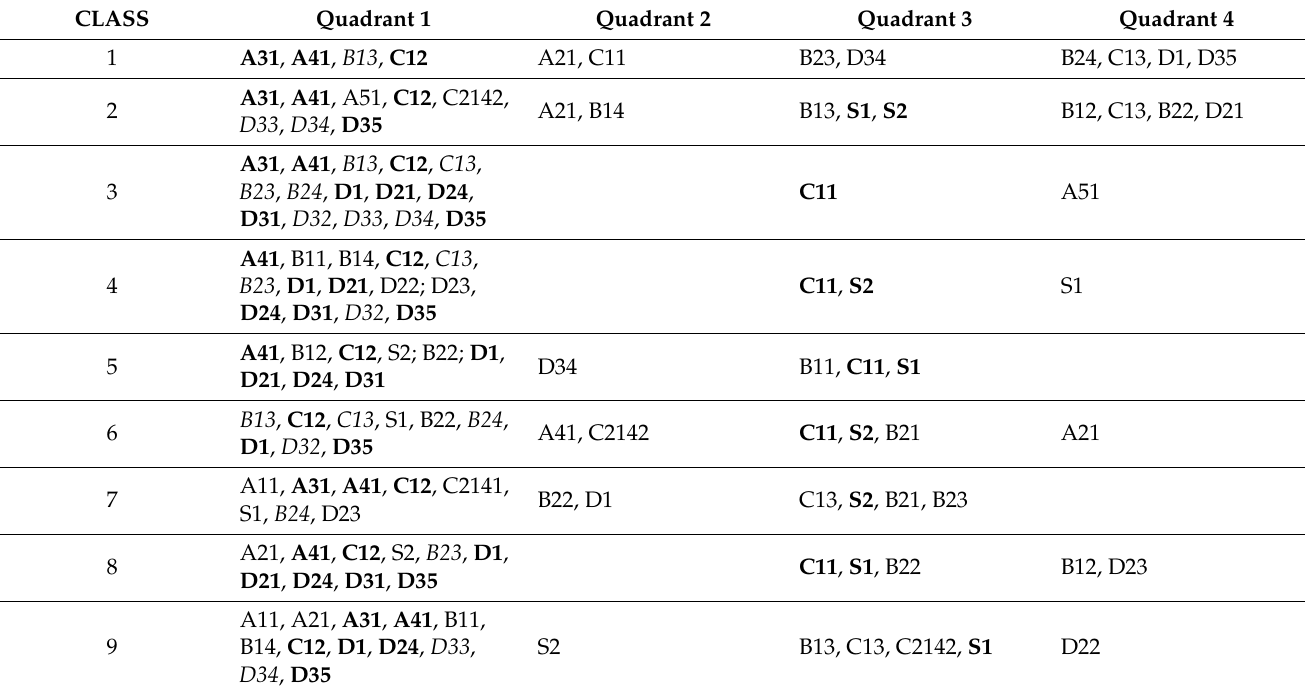
Table 8. Multiple cases: confused expression of emotions (A12) as a focal behavior with category selection as conditioned